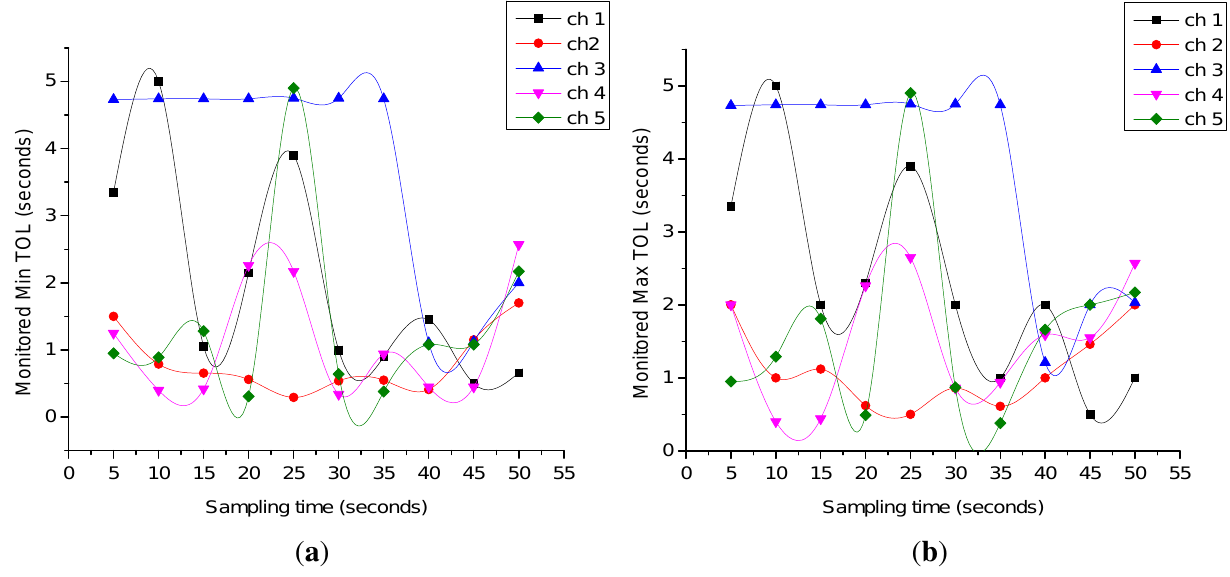
Figure 11. Monitored Min TOLs and Max TOLs. ( a ) Monitored Min TOLs; ( b ) monitored Max